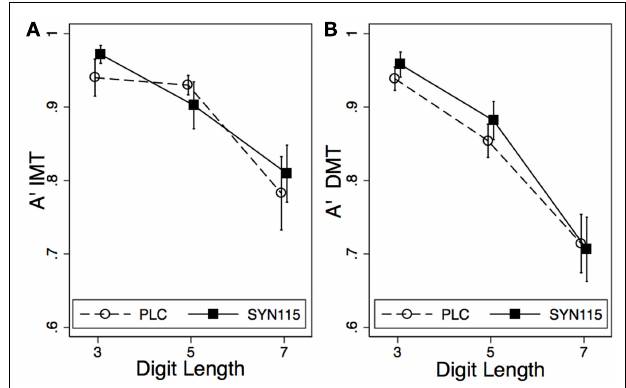
FIGURE 1 | (A) IMT A’ as a function of digit-length and drug condition with 95% confidence intervals. (B) DMT A’ as a function of digit-length and drug condition with 95% confidence intervals.